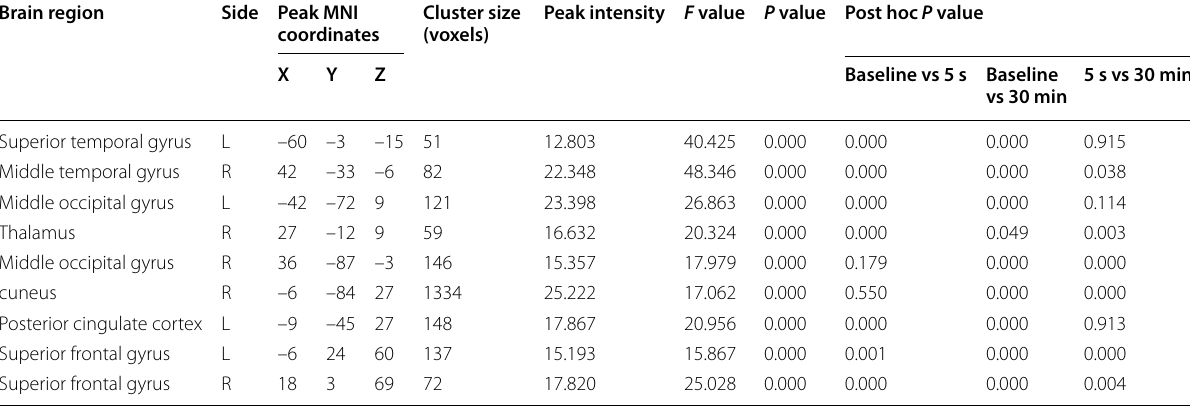
Baseline, the rs-fMRI was performed before stimulating the trigger zone; 5 s, the rs-fMRI was performed within 5 s after stimulating the trigger zone; 30 min, the rs-fMRI was performed in the 30th minute after stimulating the trigger zone CTN Classical trigeminal neuralgia, L Left, R Right, MNI Montreal Neurological Institute